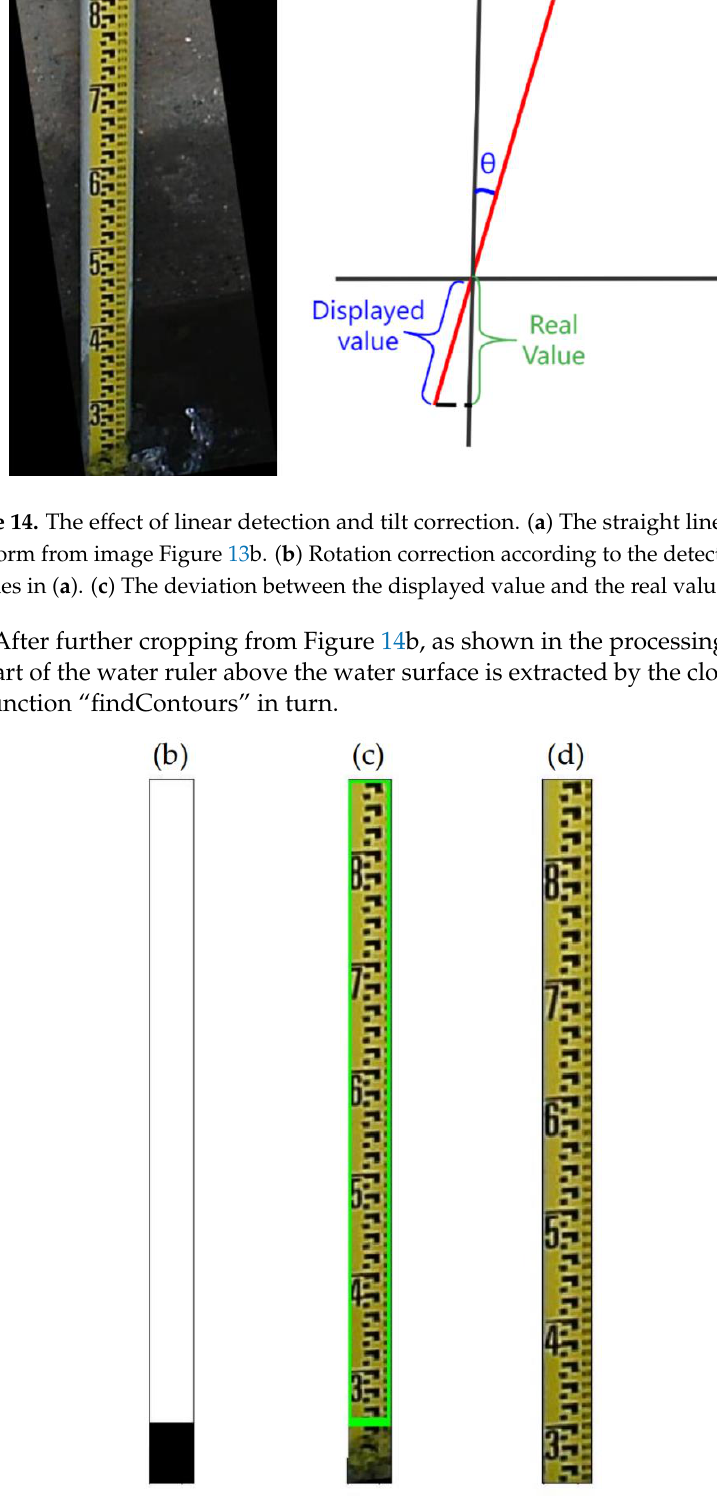
Figure 15. The water ruler image containing only the part above the water surface is extracted . ( a ) is the water ruler image truncated from Figure 14b. ( b ) is the effect of closing operation from ( a ). ( c ) is the effect of contour detection from ( b ) by using the method named “findContours”. ( d ) is the effective area extracted from the detected contour range.